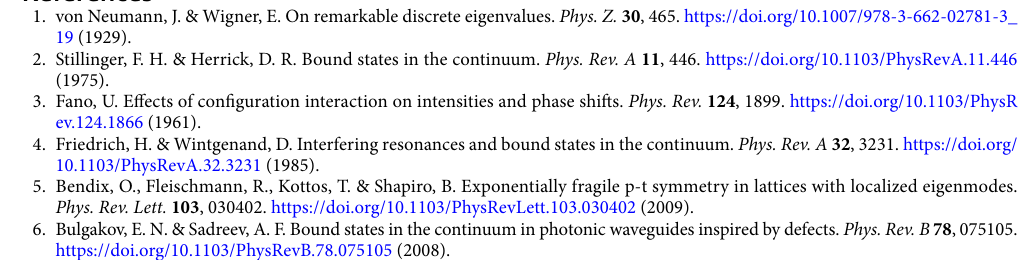
3 with same = m . From 10 . Here we take β = = x x < x 0 < 0 ), the wave functions −